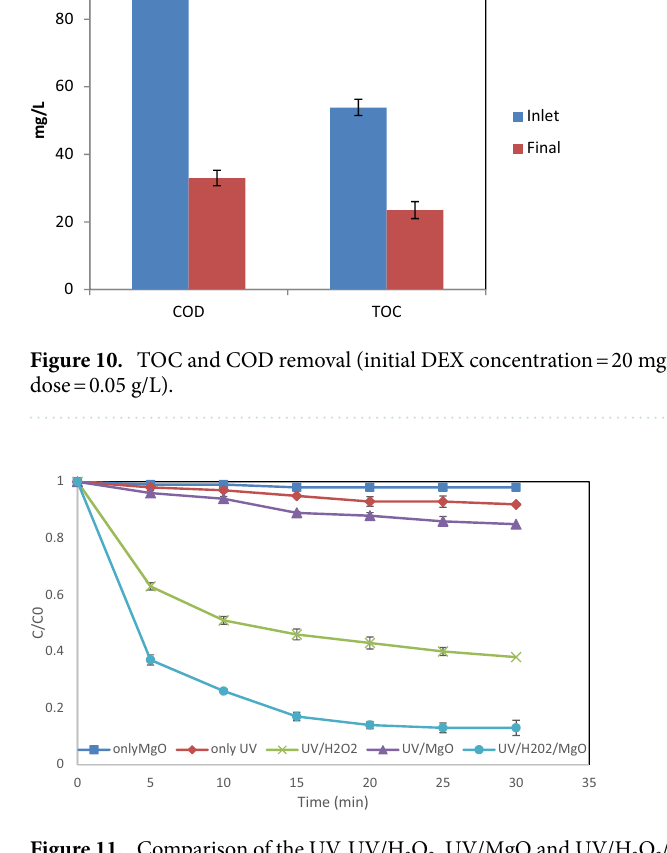
Figure 11. Comparison of the UV, UV/H 2 O 2 , UV/MgO and UV/H 2 O 2 /MgO processes under the optimum